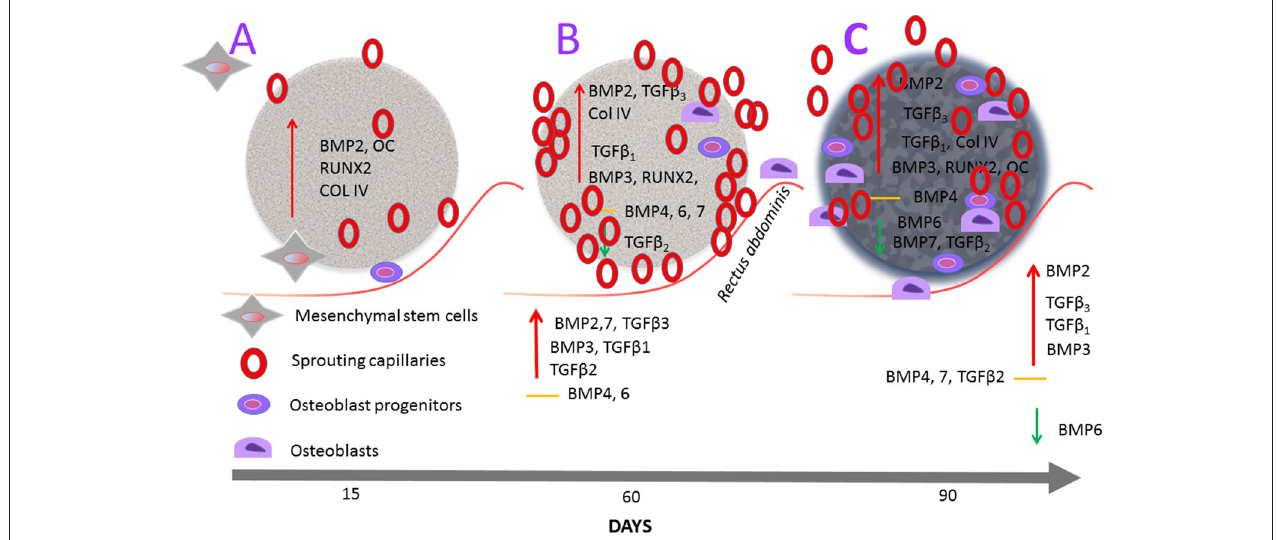
FIGURE 10 | Schematic representation of the hydroxyapatite/induced osteogenesis model by coral-derived macroporous bioreactors solo when implanted in the striated rectus abdominis muscle of Papio ursinus . Coral-derived macroporous constructs are implanted in the rectus abdominis muscle (undulated red line) of the Chacma baboon Papio ursinus . Constructs are harvested on days 15, 60, and 90 after heterotypic implantation. Undecalcified specimen blocks are embedded in Technovit and sections cut, ground, and polished at 37 µ m by the Exakt diamond saw cutting and polishing equipment. (A) There is Runx-2 , Osteocalcin , BMP-2 and Collagen type IV expression within the coral derived construct with morphologically evident sprouting capillary at the periphery of the implanted construct as well as within the macroporous spaces ( Klar et al., 2014). There is however minimal if any expression of selected genes within the surrounding enveloping striated muscle, once again indicating that the primary events of the hydroxyapatite induced osteogenic model predominately are set within the macroporous spaces. (B) On day 60, there is further angiogenesis sustained by continuous Type IV collagen over-expression together with TGF- β 1 and TGF- β 3 over-expression with however TGF- β 2 downregulation. Interestingly, there is up-regulation of BMP-3 as well as expression of BMP-4 , BMP-6 and BMP-7 . Of note, the surrounding muscle tissue on day 60 expresses BMP-2 , BMP-3, and BMP-7 with TGF- β 1 , TGF- β 2 , and TGF- β 3 with no expression of BMP-4 and BMP-6. (C) On day 90, the homogenized coral-derived construct without the enveloping striated rectus abdominis muscle show continuous up-regulation of RUNX-2 , Osteocalcin and Collagen type IV , together with up-regulation of TGF- β 1 and TGF- β 3 with downregulation of TGF- β 2 , BMP-6 and BMP-7 . The enveloping rectus abdominis muscle showed up-regulation of TGF- β 1 , TGF- β 3 , BMP-2, and BMP3 with down regulation of BMP-6. Molecular pathways correlated with the florid induction of bone formation within the macroporous spaces as shown in Figure 1